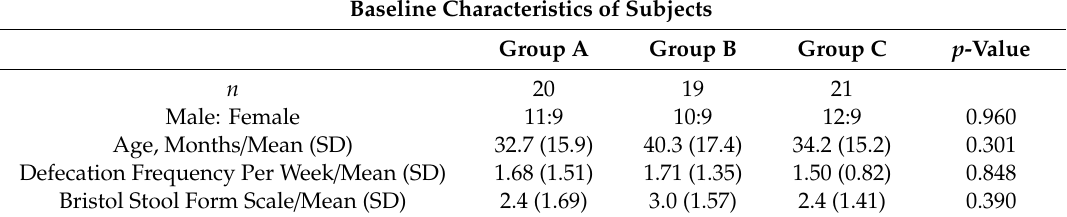
Table 1. The χ 2 test was used for the sex ratio, while other parameters were evaluated using the F-test with a one-way analysis of variance. Group A: Lactobacillus reuteri DSM 17938; group B: combination; group C: magnesium oxide.